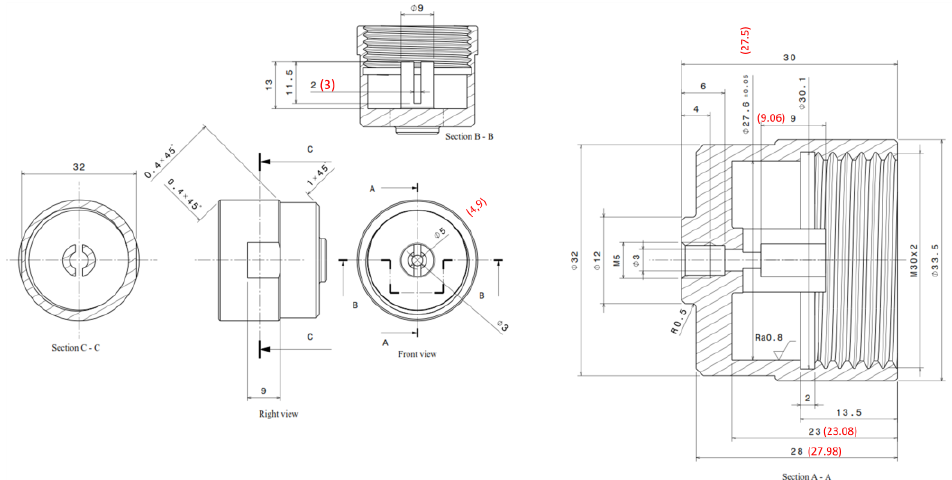
Figure A4. Mechanical drawing of the inlet flange. Parentheses (red) indicate the measured dimen- sions of the sample.